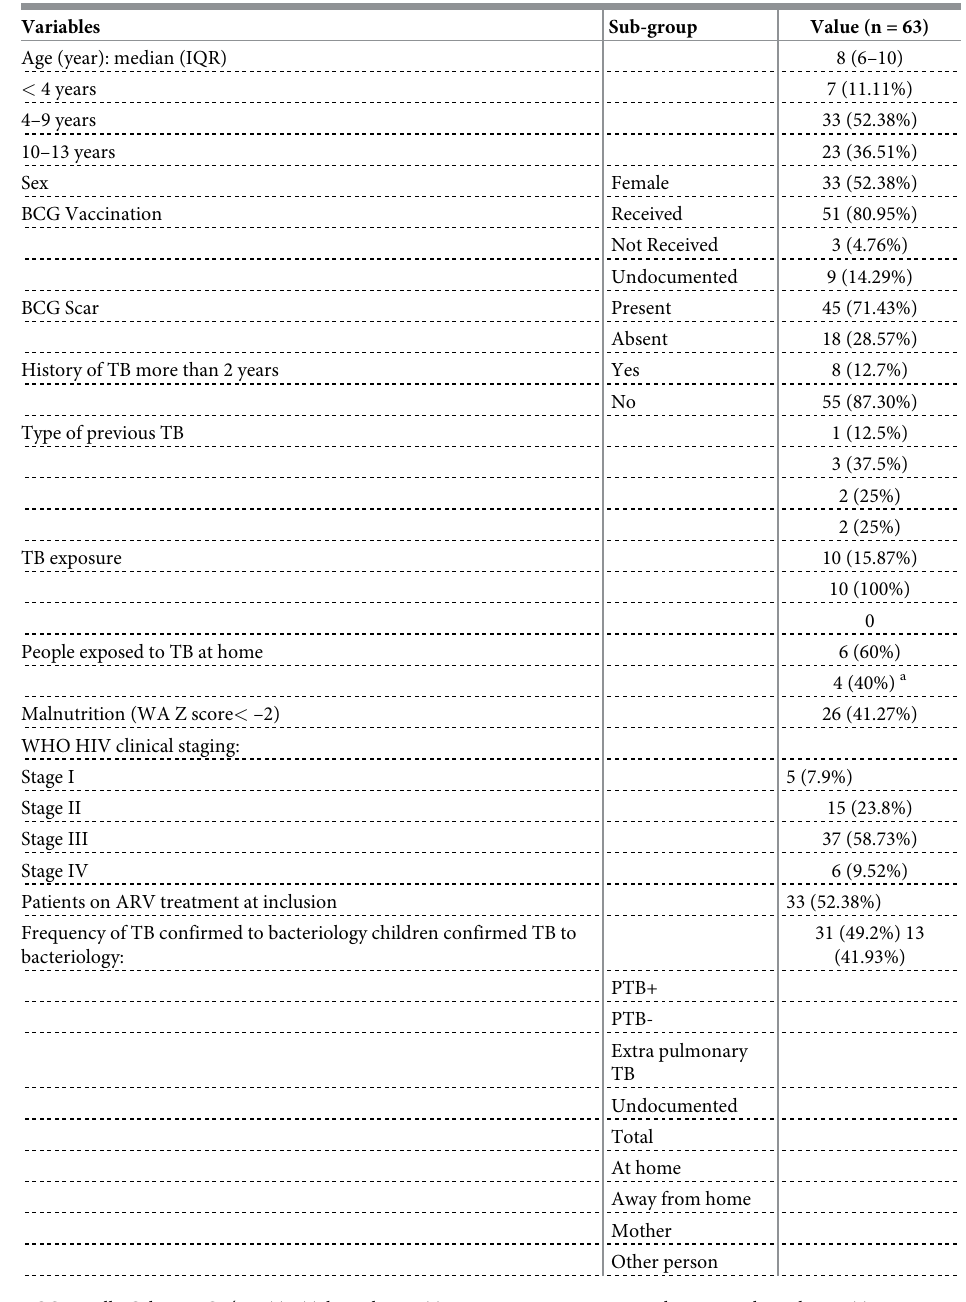
Table 1. Baseline